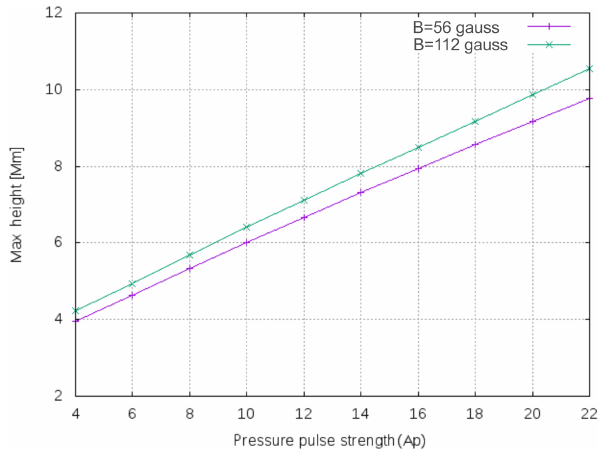
Figure 9. Maximum height of the model jets vs. pressure pulse